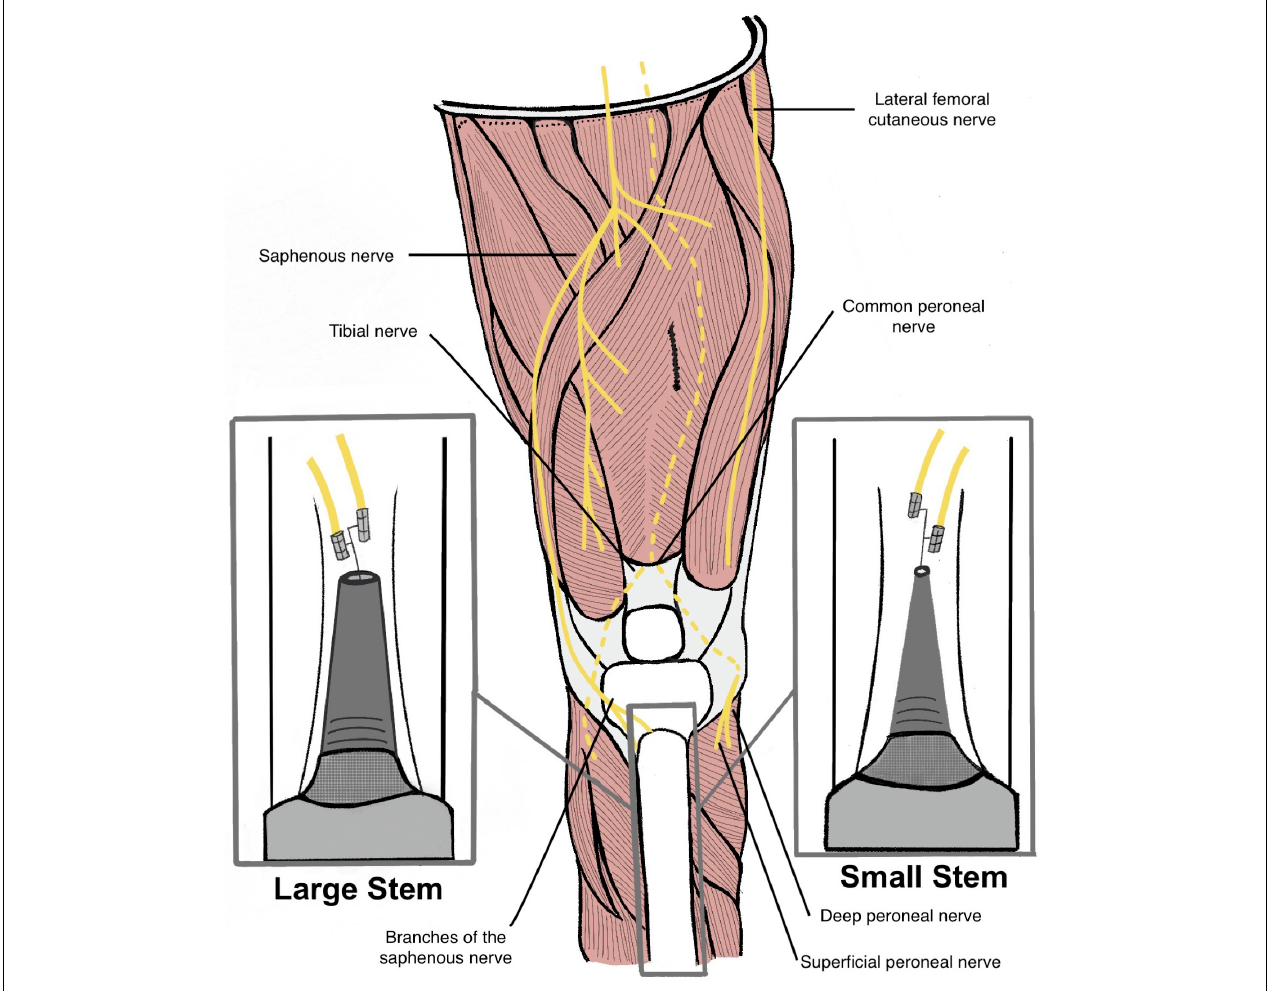
FIGURE 1 | Illustration of a transtibial amputee with a large diameter stem endoprosthesis (left) and a small diameter stem endoprosthesis (right). Red line measurements indicate the different distances between the two endoprosthesis and the medullary canal (Not to scale). Cuff electrodes are wrapped around branches of the saphenous nerve and inserted into the medullary canal via